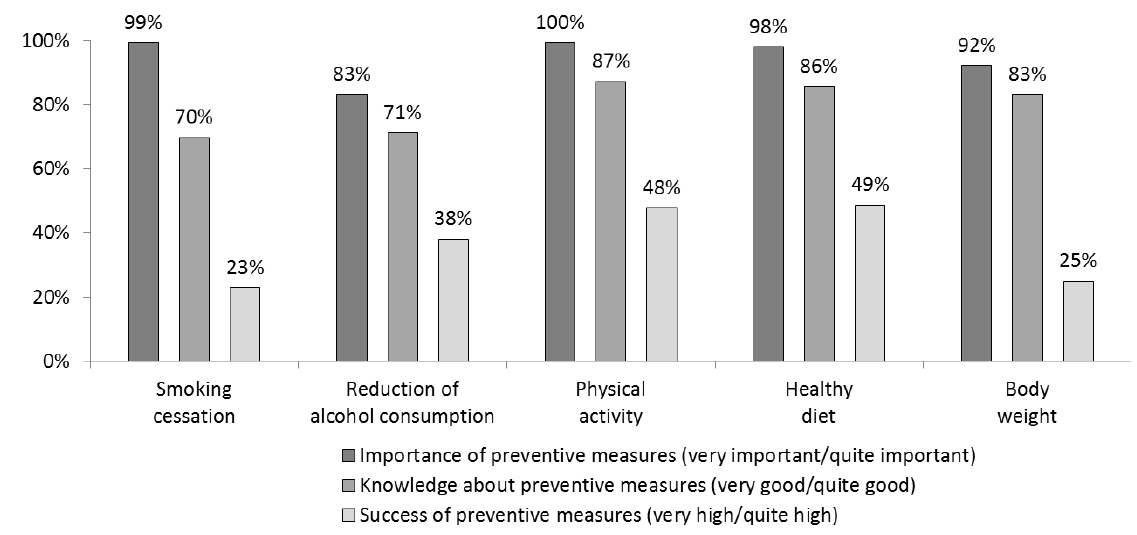
Figure 2. Importance, knowledge levels and success rates of preventative measures (% of